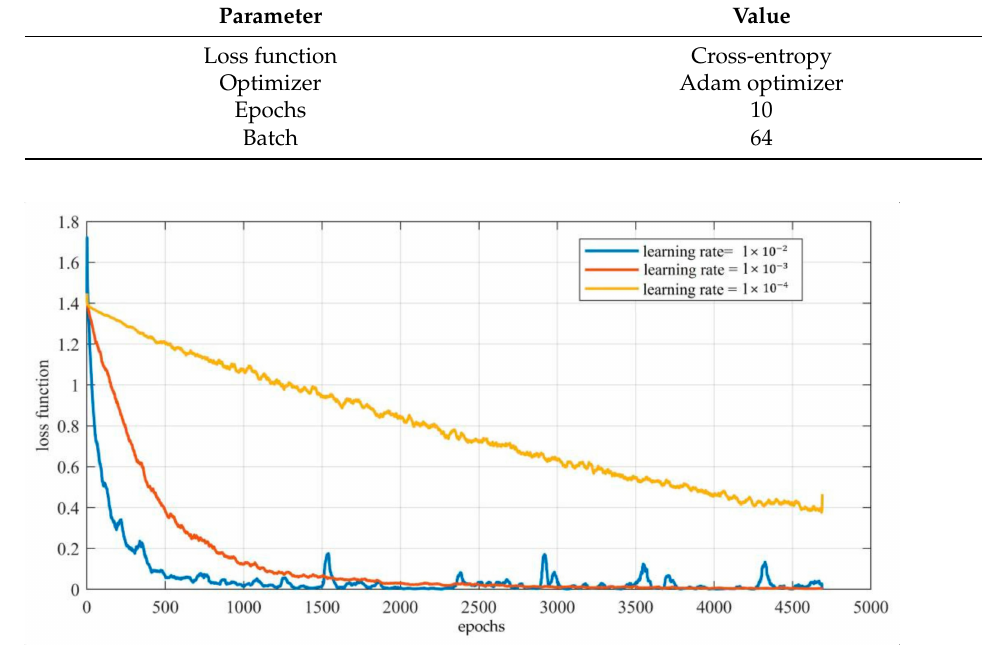
Figure 4. Loss function curve of the HTNN under different learning rates vs.